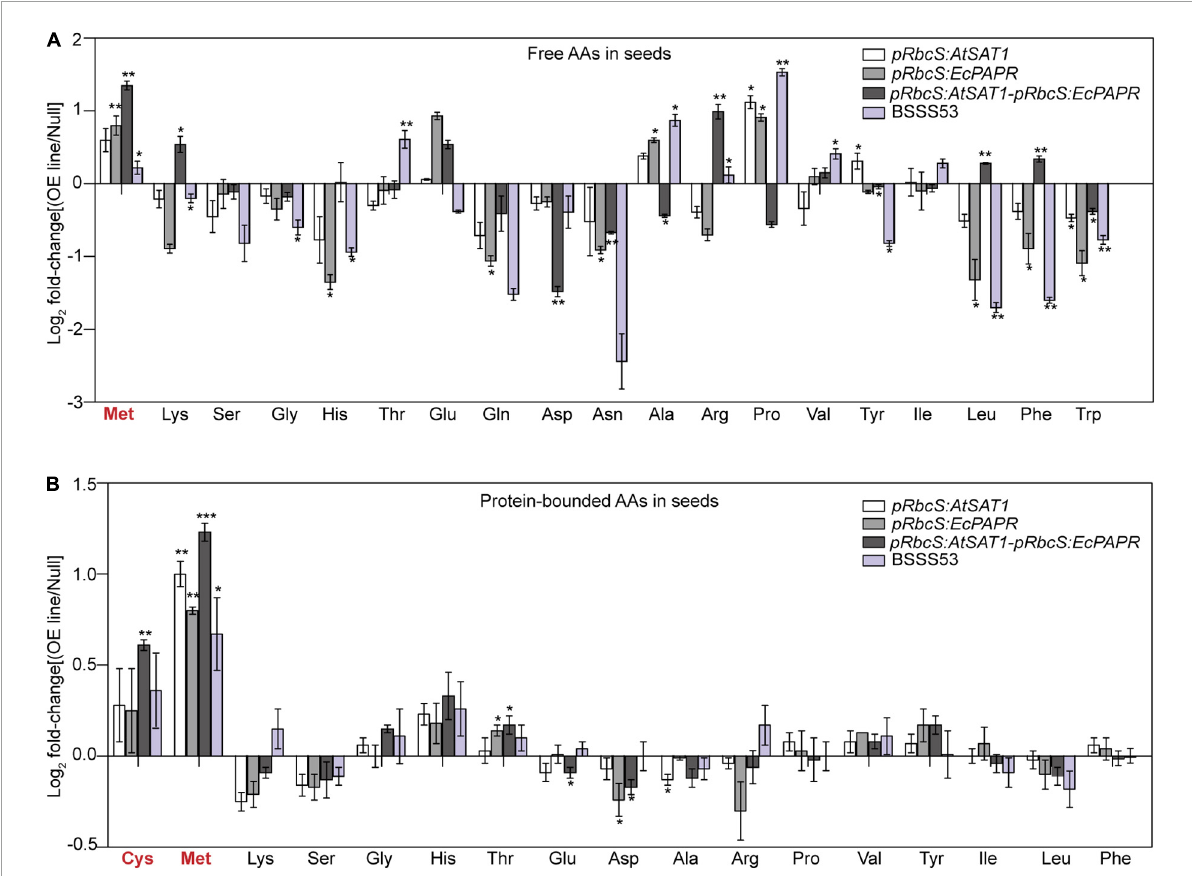
FIGURE2 Foldchanges in free and protein-bound amino acid levels in transgenic seeds compared with Null. Data were log 2 -transformed and plotted in the bar graph. (A) Free amino acid levels. (B) Protein-bound amino acid levels. Bars to the left and right indicate a reduction and an increase, respectively, in the amino acid content of the pRbcS:AtSAT1 , pRbcS:EcPAPR , pRbcS:AtSAT1-pRbcS:EcPAPR , and BSSS53 plants relative to Null. Student’s t -test at * p -value < 0.05 was used to determine the statistical significance of differences between the transgenic pRbcS:AtSAT1 , pRbcS:EcPAPR , pRbcS:AtSAT1-pRbcS:EcPAPR , BSSS3, and non-transgenic Null kernels. Data shown are means ± SD of three replicates. ** p -value ≤ 0.01 and *** p -value ≤